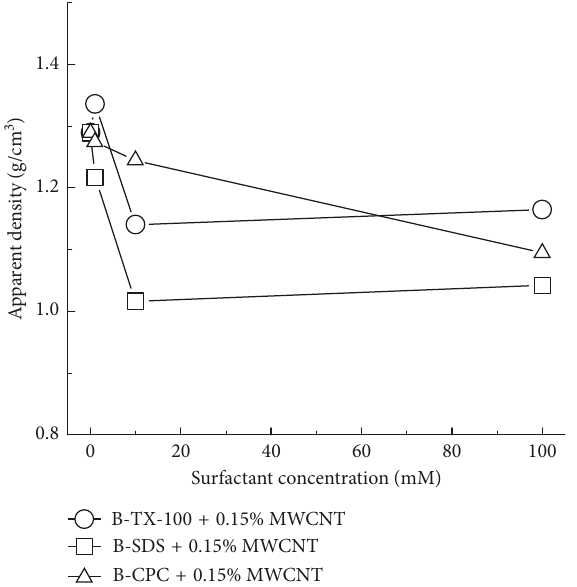
Figure 8: Apparent density of pastes with different amounts of surfactant.